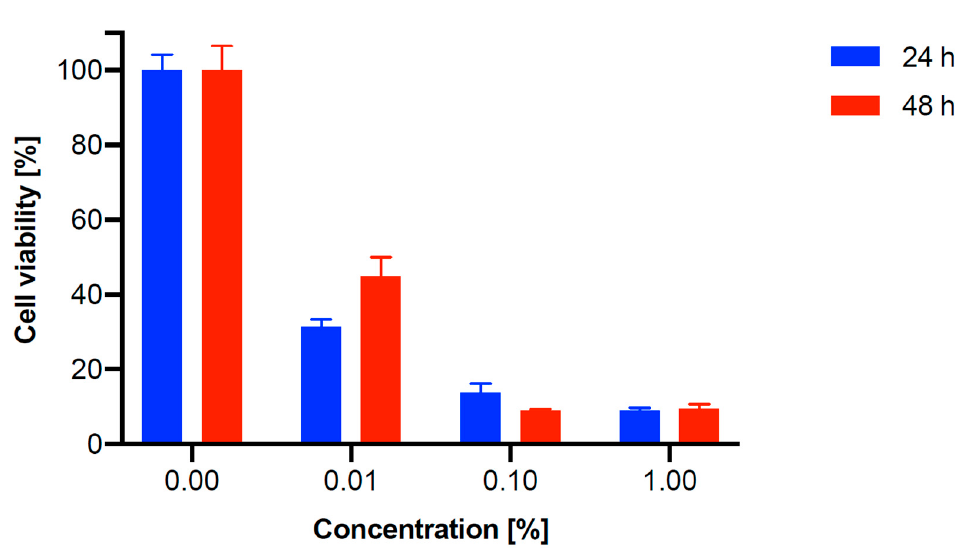
Figure 10. MTT assay on MRC-5 pd 19 cell line (human fibroblasts) after 24 and 48 h incubation for TiO 2 -GA nanomaterial.